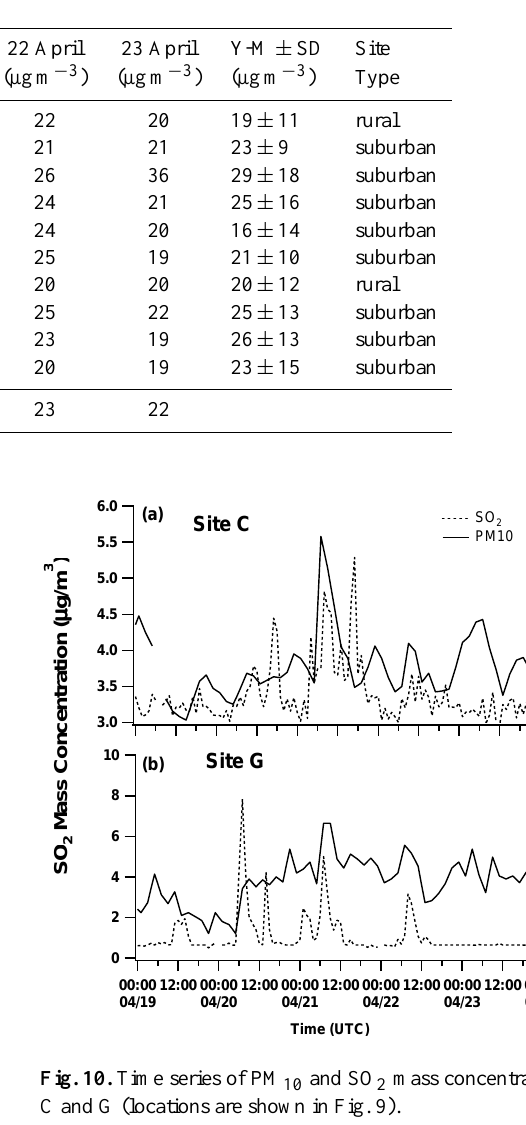
Fig. 9. Geographical locations of selected sites of the Air Quality Agency of the Apulia Region in south-eastern Italy and of the lidar site.